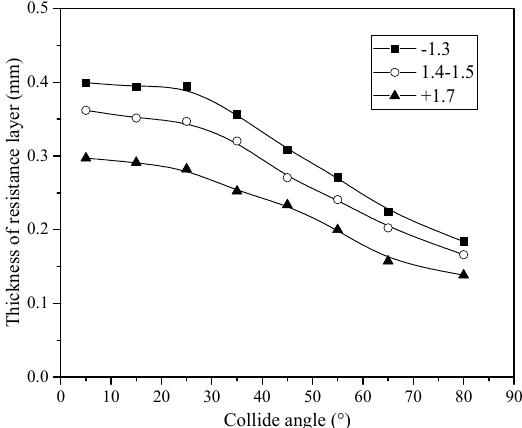
Figure 11. Boundary of coal sample resistance layer to center of bubble.